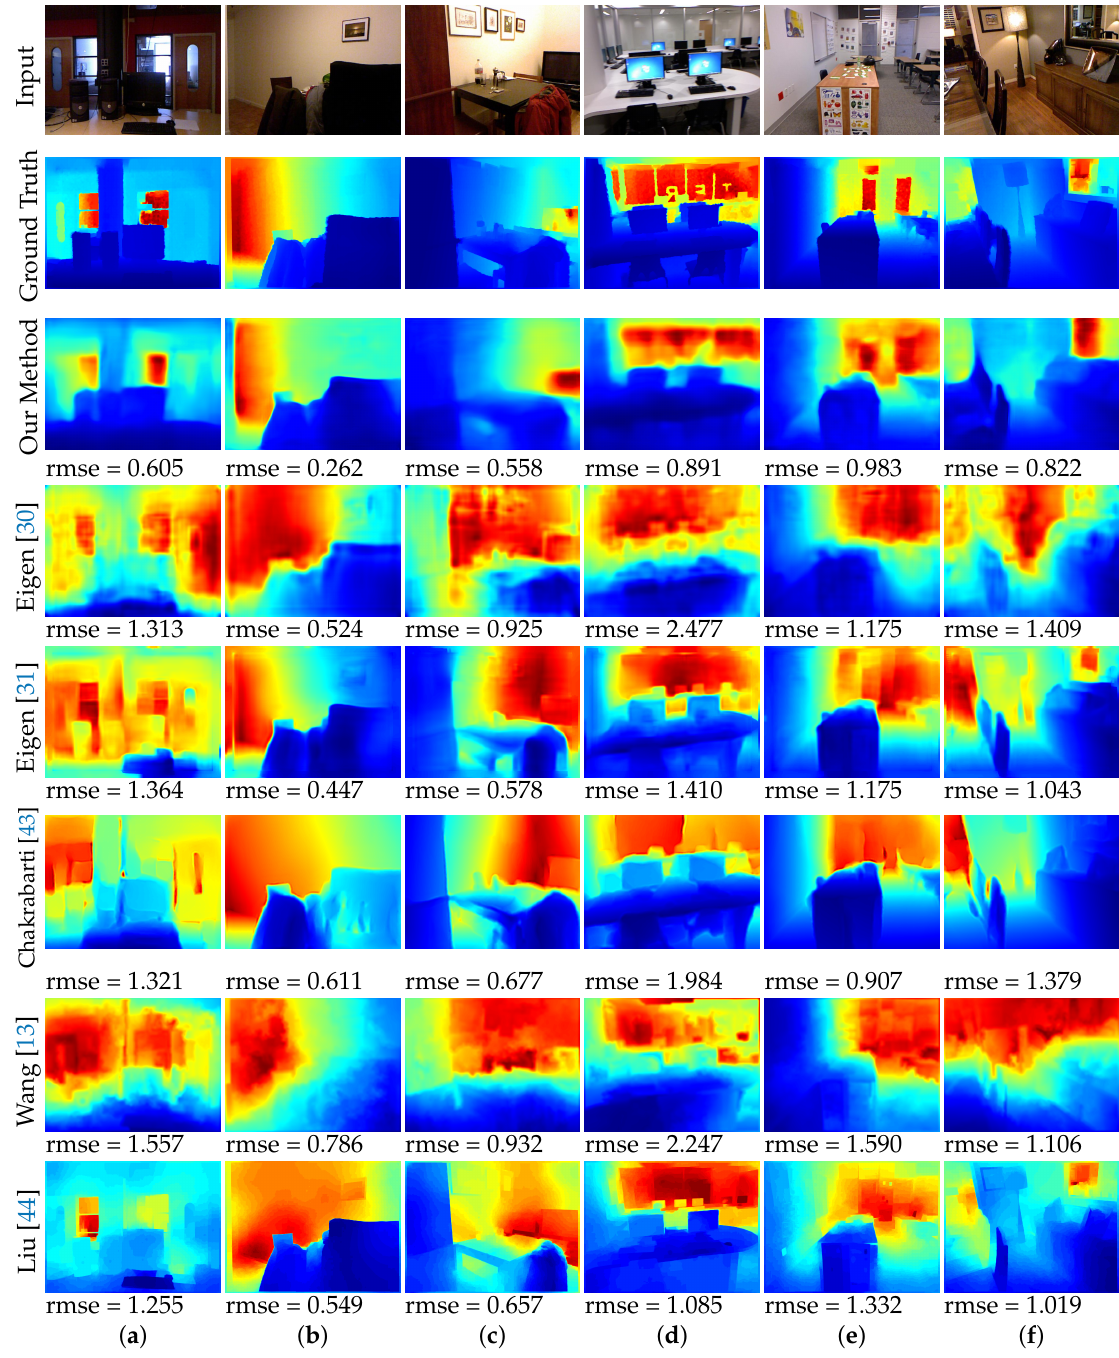
Figure 4. Visual comparison of the output of our model with the several state-of-the-art